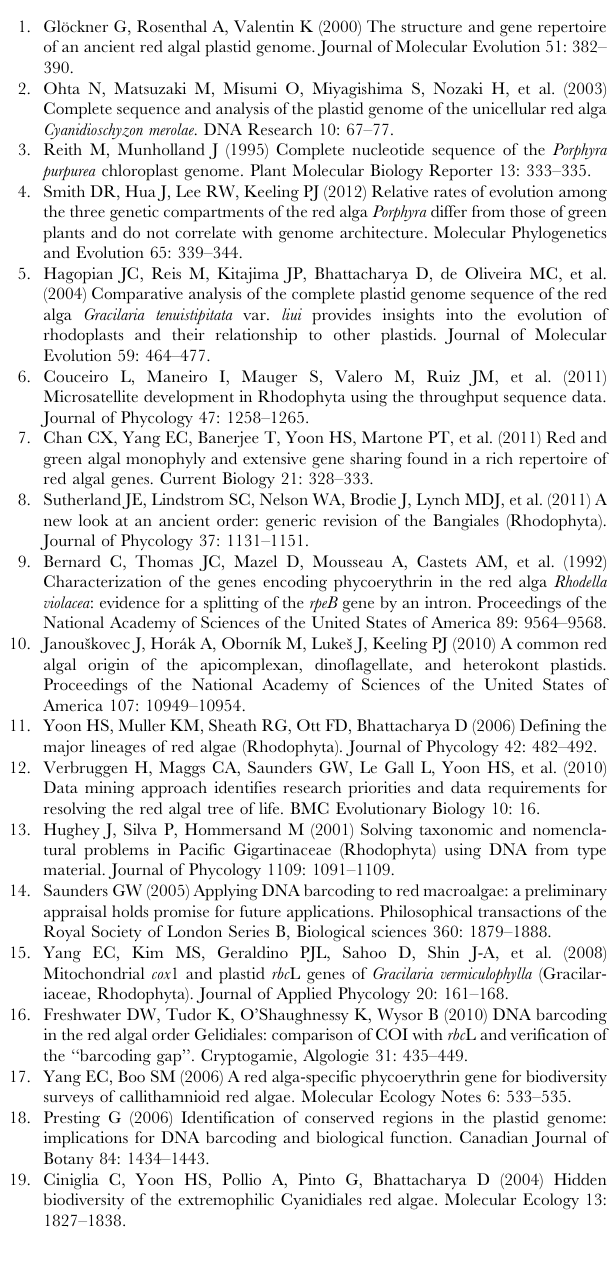
Figure S3 Plastid gene dN rates. Boxplot is showing relative nonsynonymous substitution rates (dN) and their standard de- viation (interquartile range; IQR) for all selected red algal plastid genes including rbcL , mitochondrial c ox1 and 5 9 coding region of cox1 ( 5 9 cox1 ). Median is indicated by a solid line, the sample minimum and maximum are indicated by dotted lines and bars outside the box, and outliers are indicated by open circles. For comparison, the positions of rbcL and a dN of 0.5 are highlighted. Table S1 Annotation changes in publicly available red algal plastid genomes. Table S2 Boxplot statistics of nonsynonymous substitution rates estimated using Maximum